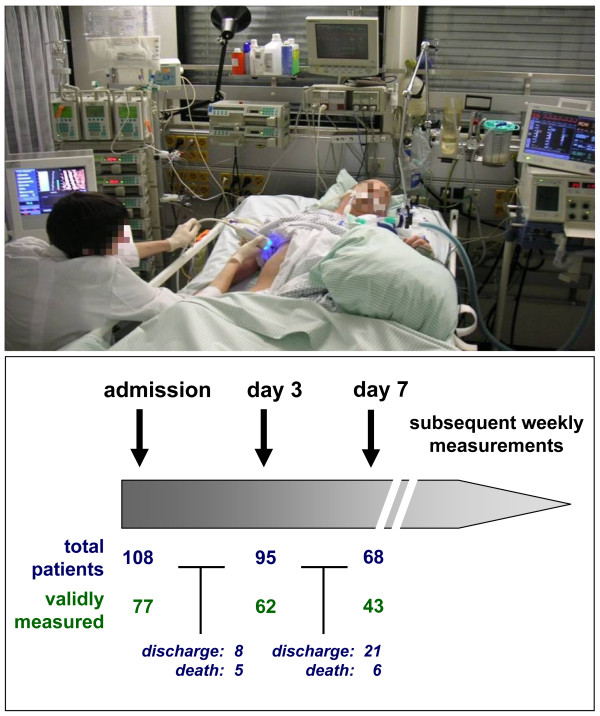
Liver stiffness measurements in the intensive care unit (ICU) setting. Critically ill medical patients were included into this study upon admission to the ICU. Transient liver elastography was assessed at admission, on Day 3, on Day 7, and subsequently once per week. The setting of our study is displayed in the upper panel; stiffness measurements were performed at the bedside with a portable FibroScan® apparatus, alongside classical hemodynamic and respiratory monitoring as well as typical ICU treatment measures. The numbers of patients included into the study and the numbers of ICU patients with valid liver stiffness measurements are given in the lower panel of the figure. The numbers of drop-outs, due to transferral to standard care or death, are also displayed.